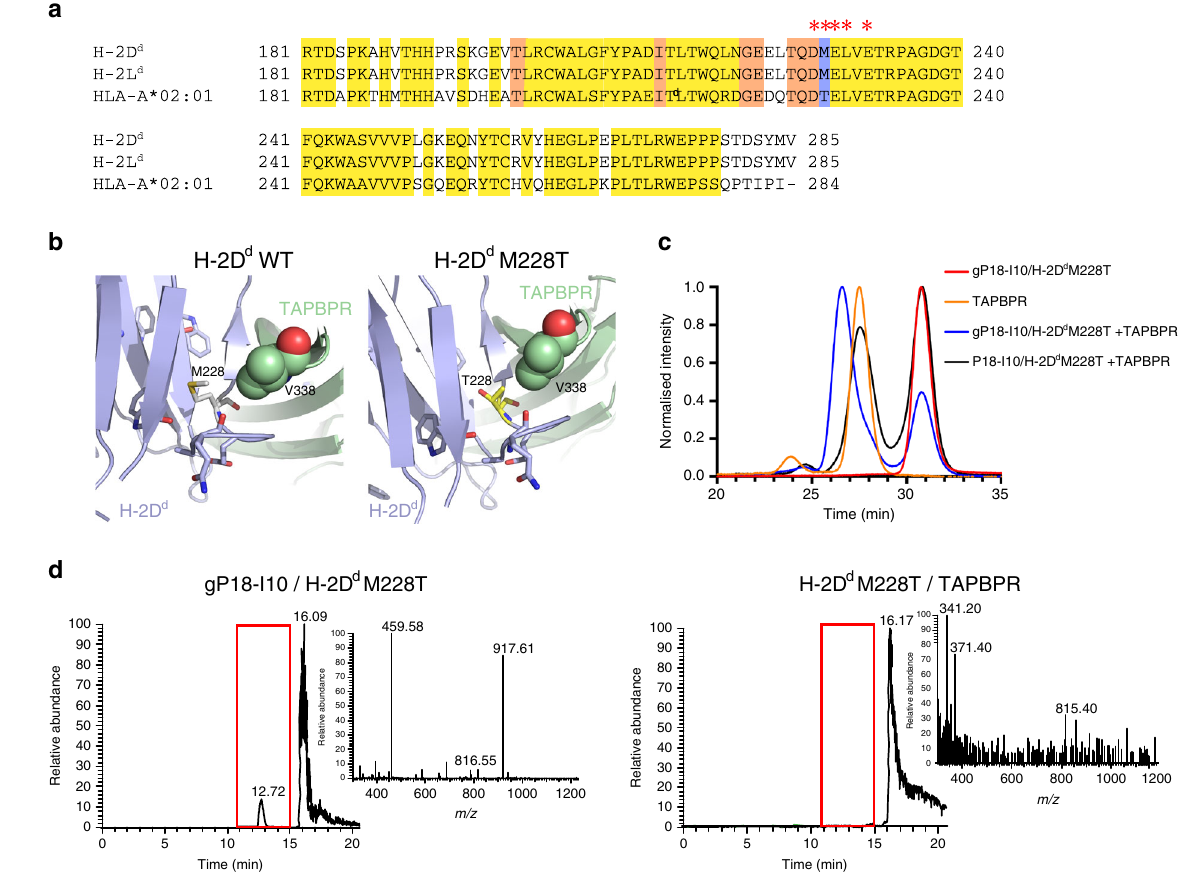
Fig. 6 Fine-tuning MHC-I/TAPBPR interactions through α 3 domain mutants. a Alignment of the α 3 domain sequences from murine H-2D d , H-2L d and human HLA-A*02:01. Conserved residues are highlighted in yellow. The M228T mutation site is highlighted in blue. * indicates residues directly participating in TAPBPR interactions, as shown in published mutagenesis studies and crystal structures. b TAPBPR/H-2D d α 3 domain interface from PDB ID 5WER 5 (left panel) and with the M228T mutation modeled (right panel). c Size exclusion chromatograms of H-2D d M228T refolded with either high- af fi nity P18-I10 or goldilocks gP18-I10 peptides, with and without TAPBPR. d LC/MS analysis of the peptide region from SEC-puri fi ed gP18/H-2D d M228T and H-2D d M228T/TAPBPR peaks from ( c ). Data shown are representative of triplicate SEC and LC/MS